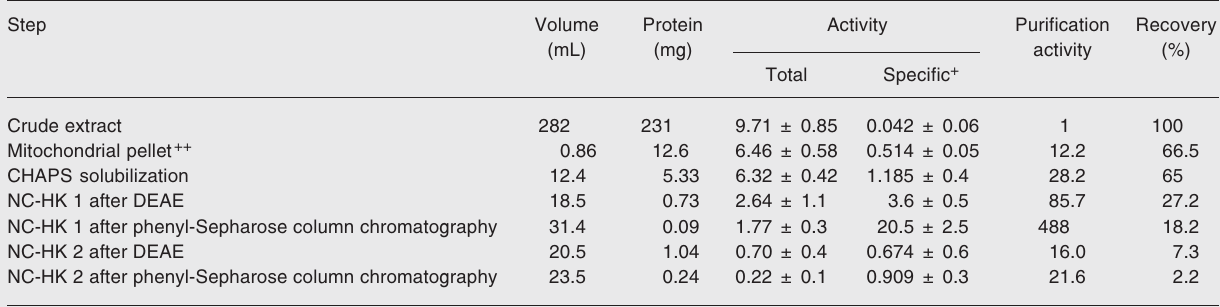
Table 1. Purification of non-cytosolic hexokinases from maize